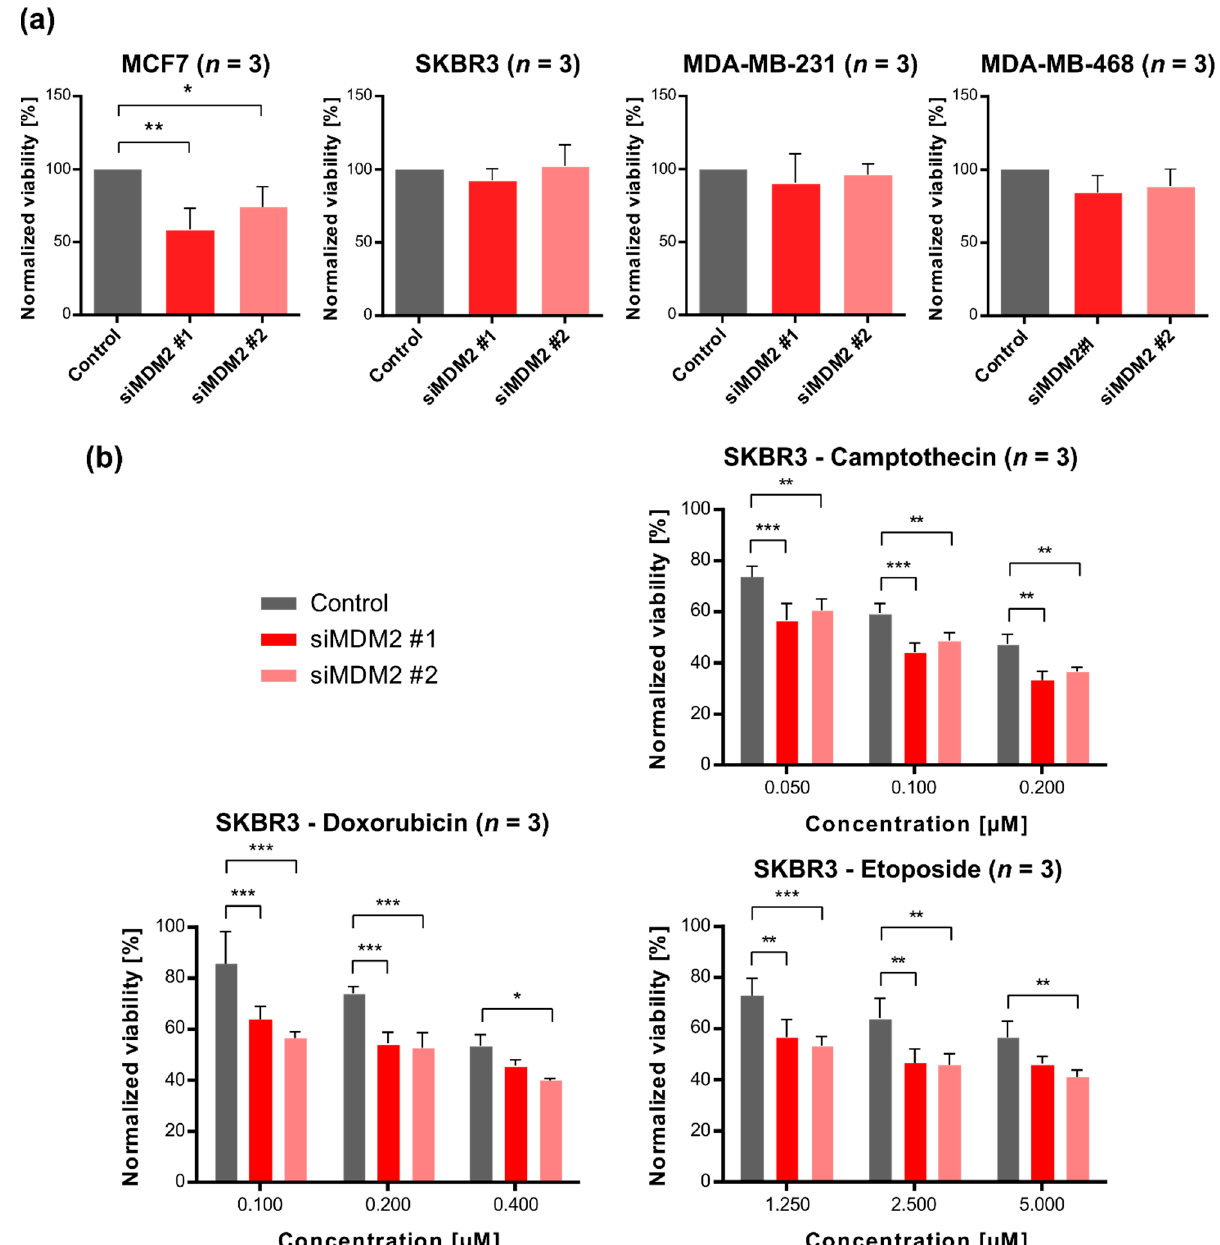
Figure 2. Cell viability after silencing of MDM2 gene expression with and without treatment with chemotherapeutics. Cell survival was assessed by metabolic activity assay after silencing of MDM2 gene expression using siRNA (siMDM2#1, siMDM2#2). ( a ) Cell viability following downregulation of MDM2 gene expression in a panel of breast cancer cell lines. The viability was assayed 72 h post-transfection and normalized to cells transfected with non-specific siRNA (control). ( b ) Viability of SKBR3 cells (HER2-enriched subtype) transfected with non-specific siRNA (control) or one of two different MDM2 -silencing siRNAs (siMDM2#1, siMDM2#2) and treated for 72 h with various concentrations of DNA-damaging chemotherapeutic agents (camptothecin, doxorubicin, etoposide). For each transfection viability was normalized to non- treated cells. Statistical significance was assessed by comparing two silencing sequences (siMDM2#1, siMDM2#2) with the control (non-specific siRNA) at each concentration of the chemotherapeutic agent, * p < 0.05, ** p < 0.01, *** p < 0.001. Three independent biological experiments were performed for each chemotherapeutic ( n = 3).